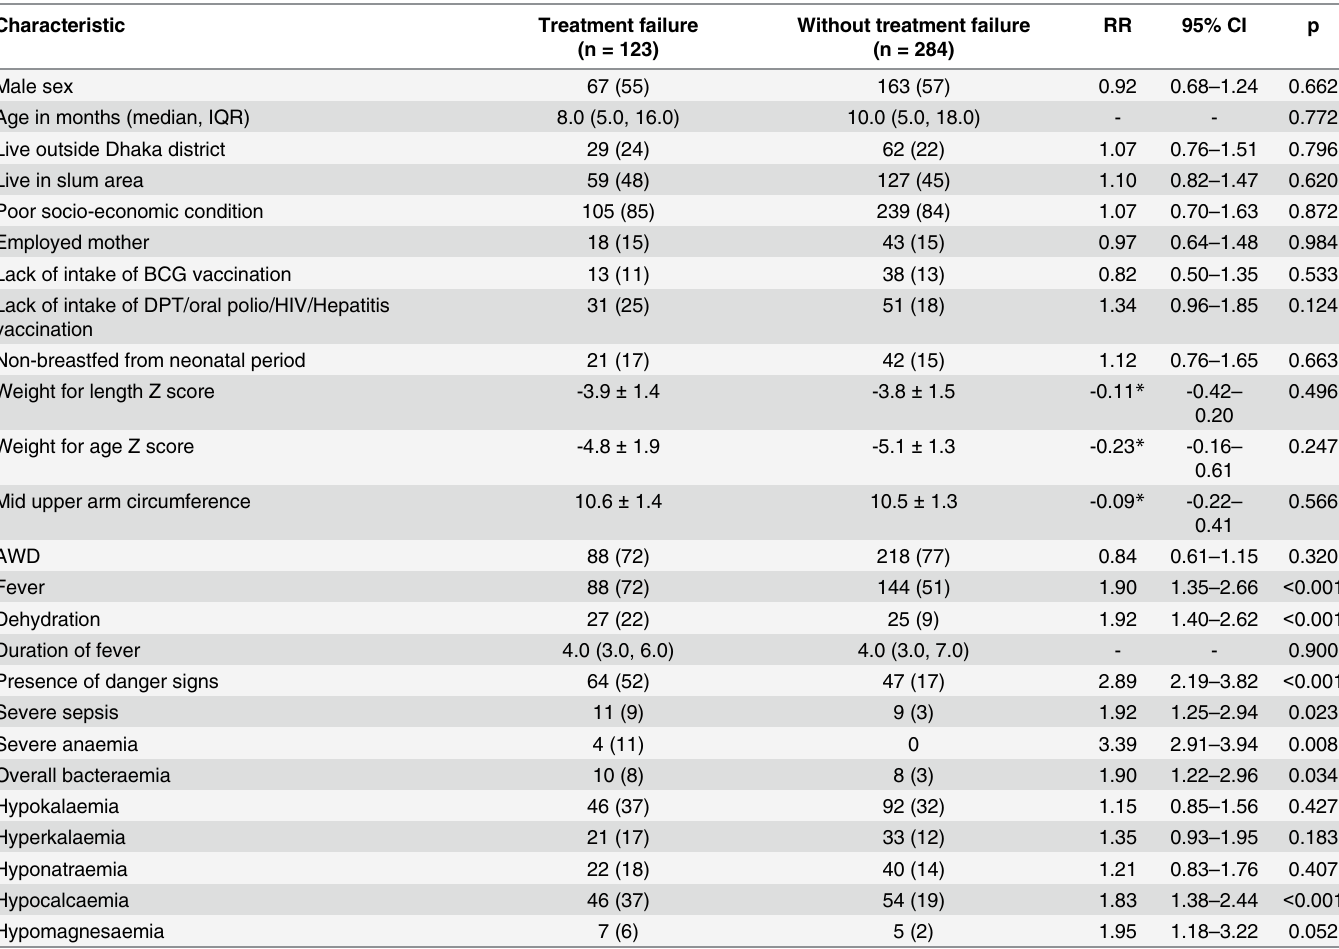
Table 3. Factors present on admission that were associated with treatment failure during hospitalisation in under-five, severely malnourished chil- dren presenting with cough or respiratory difficulty and radiological pneumonia.